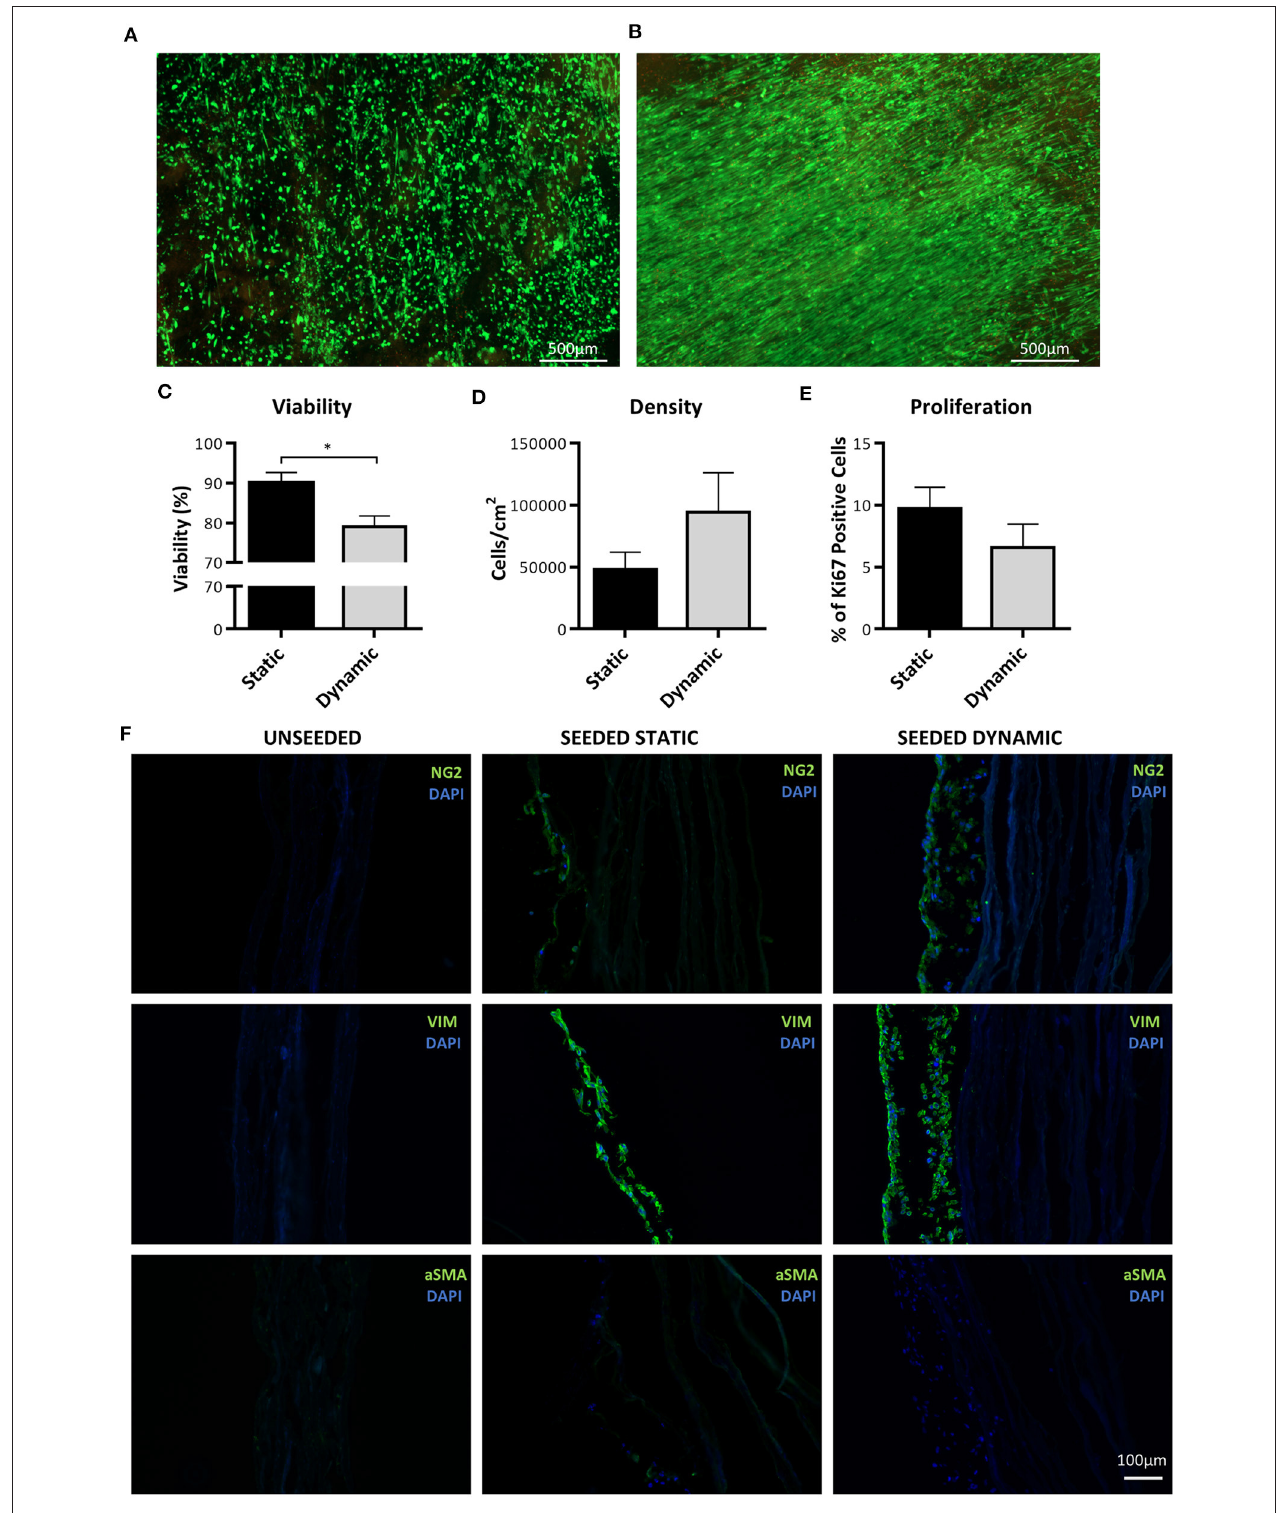
FIGURE 8 | Analysis of cell engraftment on CorMatrix graft. (A,B) Representative images of cell distribution and viability after conditioning on CorMatrix scaffold. (A) static conditioning. (B) dynamic conditioning. Cytoplasmic green fluorescence, live (Calcein AM) cells; Nuclear red fluorescence, dead (ethidium homodimer-1) cells. (C) Cell viability. (D) Cell density (E) Cell proliferation. (F) Representative immunohistochemical images demonstrating NG2 UCP presence in graft. Static = 5 days static conditioning, dynamic = 5 days static plus 7 days dynamic conditioning. Data represent means ( ± S.E.M). n = 4 biological replicates. * p < 0.05.